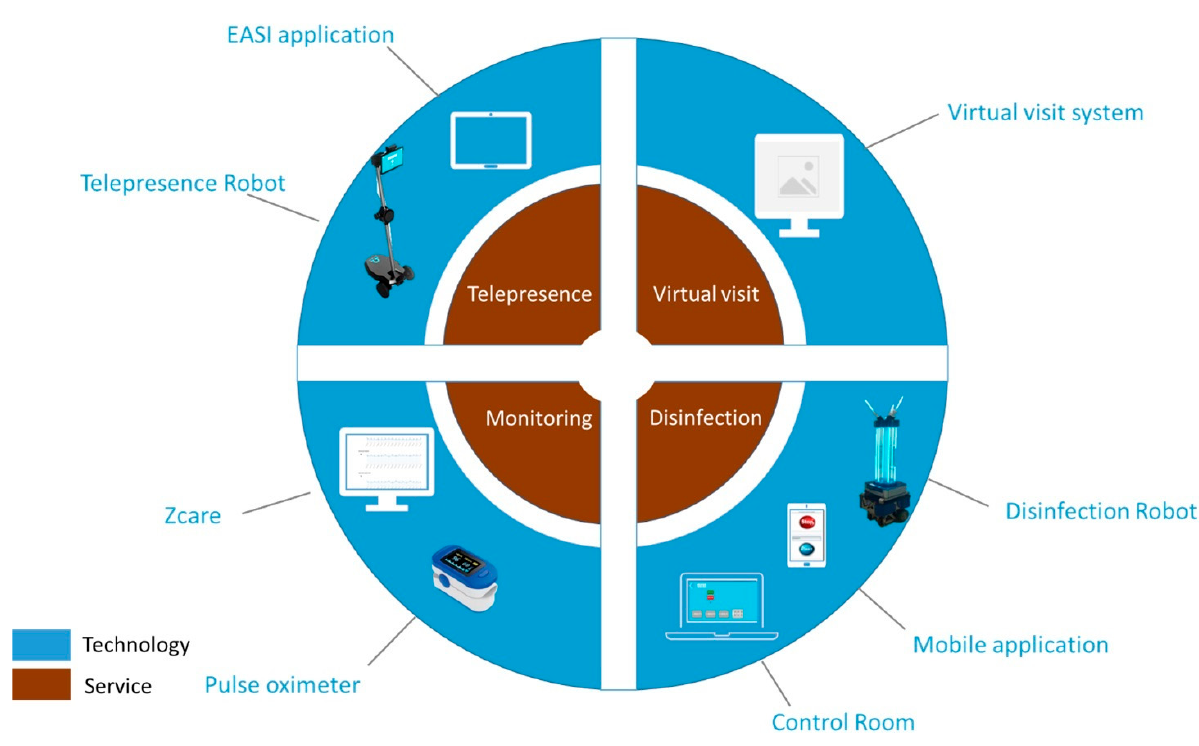
Figure 2. Overview of the assistive technology used within the proposed fast pilot. The telepresence service was performed with the robot and with the tablet. As for the telepresence service with the robot, two telepresence robots were used: Ohmni and Double